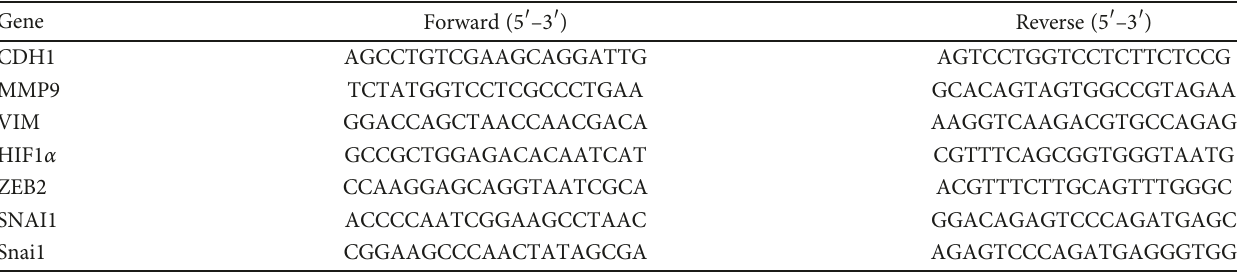
Table 1: SYBR Green primer sets used in QPCR experiments.